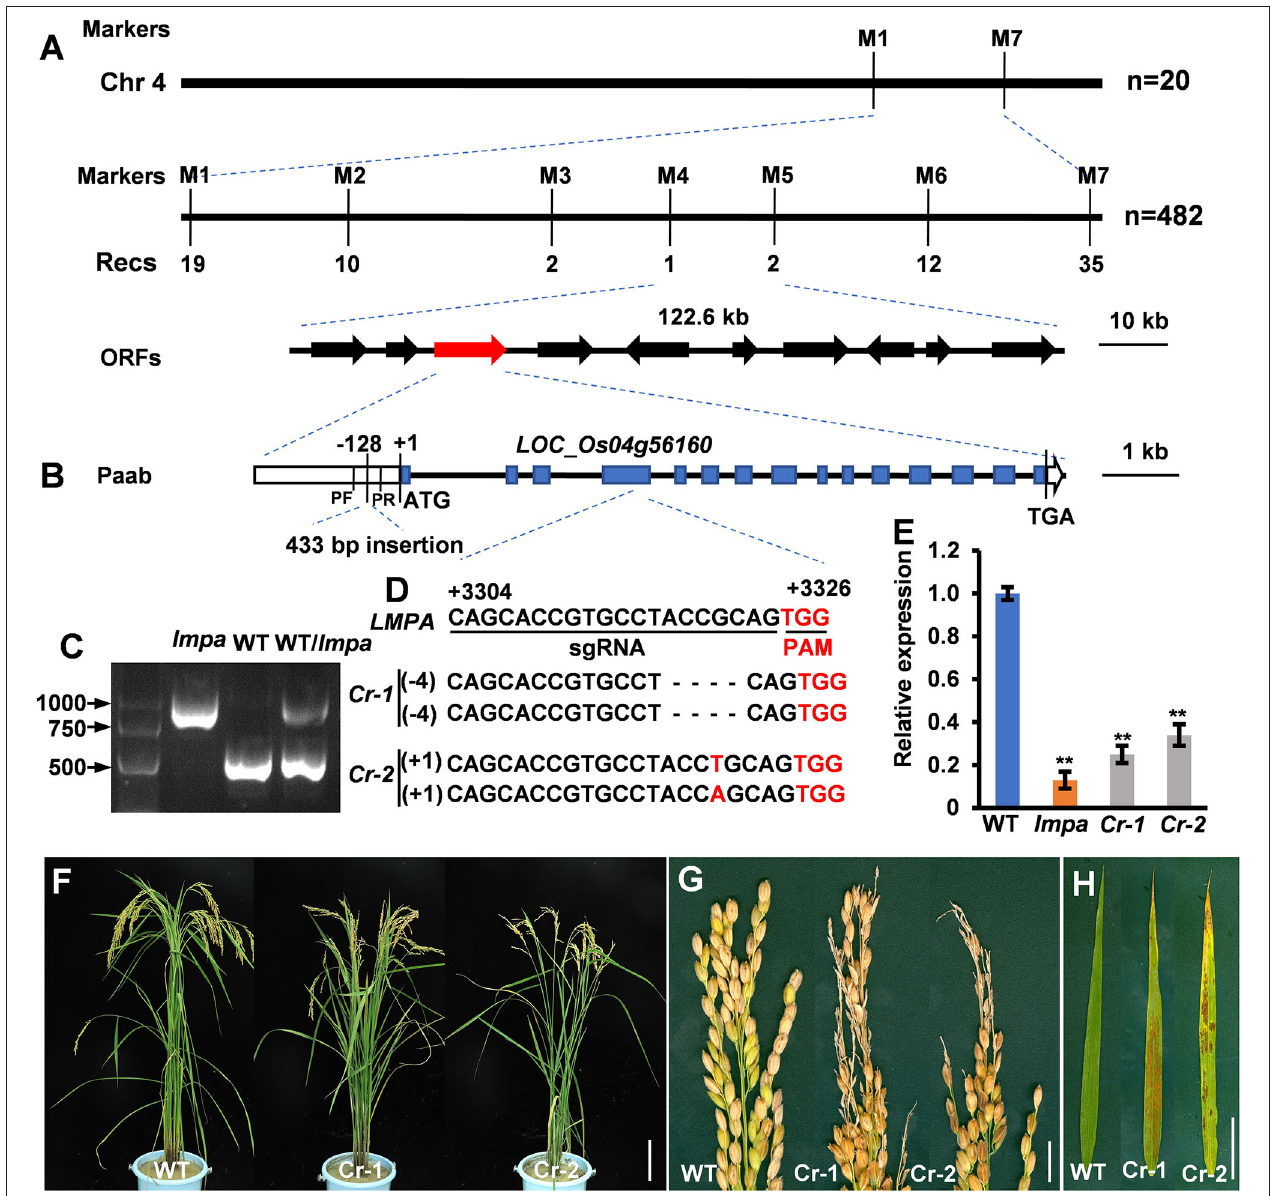
FIGURE 5 | Map-based cloning of lmpa . (A) Fine mapping of lmpa . (B) Gene structure of the candidate gene. (C) Agarose electrophoresis confirmation of the mutation. DNA fragments were amplified using pF and pR primers indicated in (B) . (D) Deletion mutation at the target site in two representative knockout lines generated by the CRISPR/Cas9 technology. (E) Expression levels of lmpa in WT, lmpa mutant, and two knockout mutant lines. (F–H) Phenotypes of WT and knockout mutant plants. Error bars represent standard deviation (SD) ( n = 3); **Significant difference at p < 0.01 compared with the WT by Student’s t -test. Bars = 10cm in (F) , 1cm in (G,H)